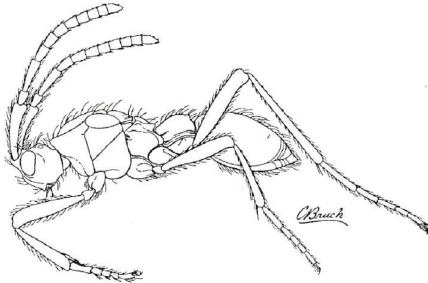
Figure 5: Original illustration of Notoxoides pronotalis female in lateral view, by Bruch.